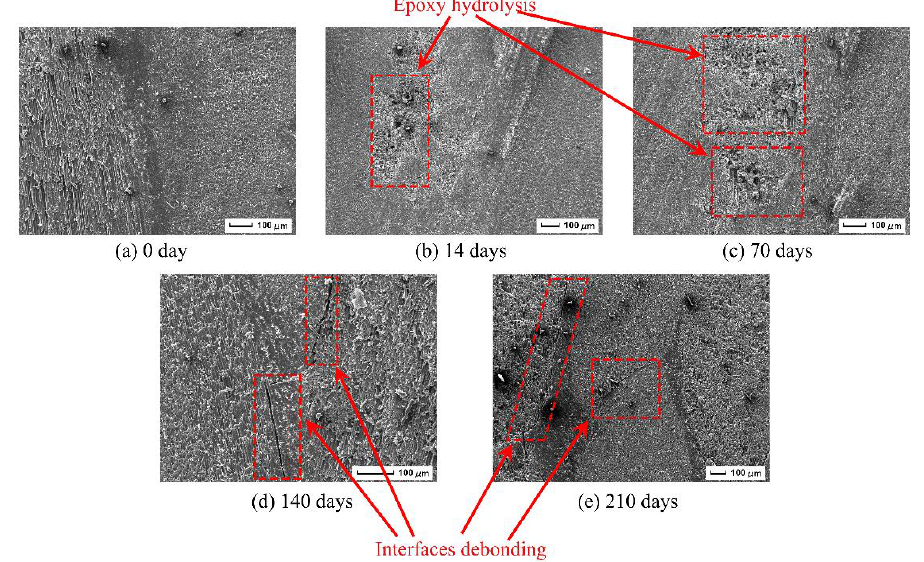
Figure 10. Damage evolution on the cross section of the 3D four-step braided composites after different cyclic hygrothermal aging days, ( a ) 0 day, ( b ) 14 days, ( c ) 70 days, ( d ) 140 days, ( e ) 210 days.